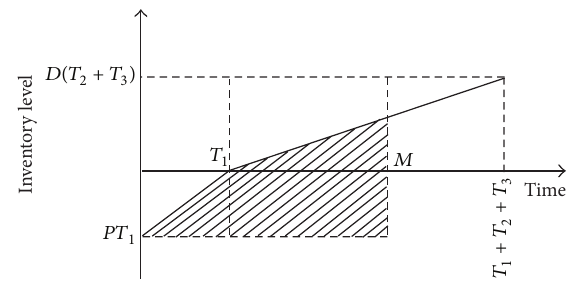
Figure 3: The total accumulation of interest earned when 𝑇 1 ≤ 𝑀 ≤ + 𝑇 + 𝑇 𝑇 1 2 3 .